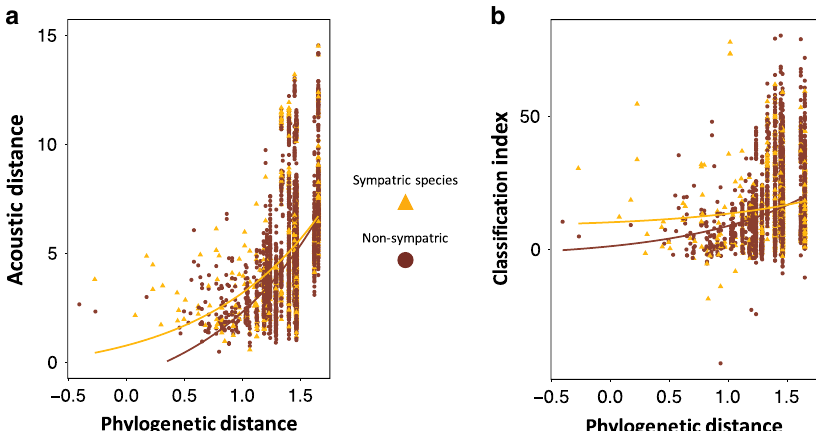
Fig. 7 Effect of sympatry on the relationship between drumming acoustic structure and species-speci fi c information content. a Relationship between acoustic (Euclidean) and phylogenetic (million years, log-transformed) distances between species. Each dot represents a pair of species. Acoustic distances are computed as the Euclidean distance between 22-dimension vectors (for 22 drumming acoustic features; one vector per species). Within panel ( a ): closely related species have more similar signals, which are more likely to be affected by sympatry; i.e. character displacement due to sympatry only occurs for low phylogenetic distances, see statistics in Supplementary Table 10. b Relationship between the Classi fi cation Index (ranging from − 100 to 100) and phylogenetic distance (log-transformed) between species. Each dot represents a pair of species. Within panel ( b ): signals from closely related species are more likely to be affected by sympatry to increase potential classi fi cation between species; i.e. increase of correct classi fi cation due to sympatry (through the character displacement observed in panel a ) only occurs for low phylogenetic distances, see statistics in Supplementary Table 10. Source data are provided as a Source data fi